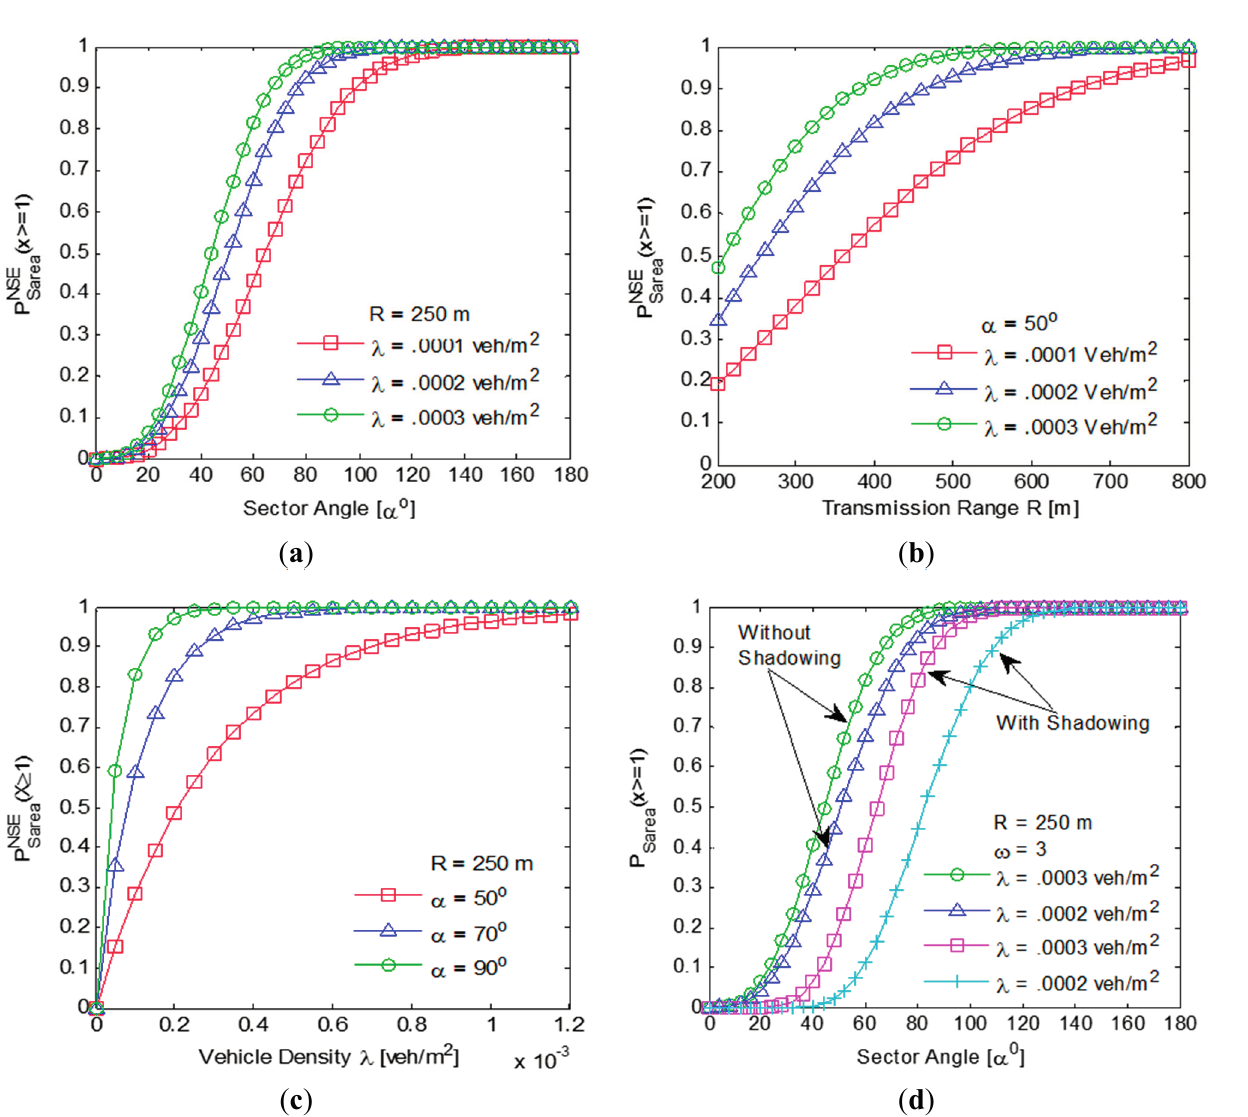
((cid:1850) ≥ 1) is shown in Figure 8. (cid:3015)(cid:3020)(cid:3006) ((cid:1850) ≥ 1) and (cid:1842) (cid:3020) (cid:3276)(cid:3293)(cid:3280)(cid:3276)